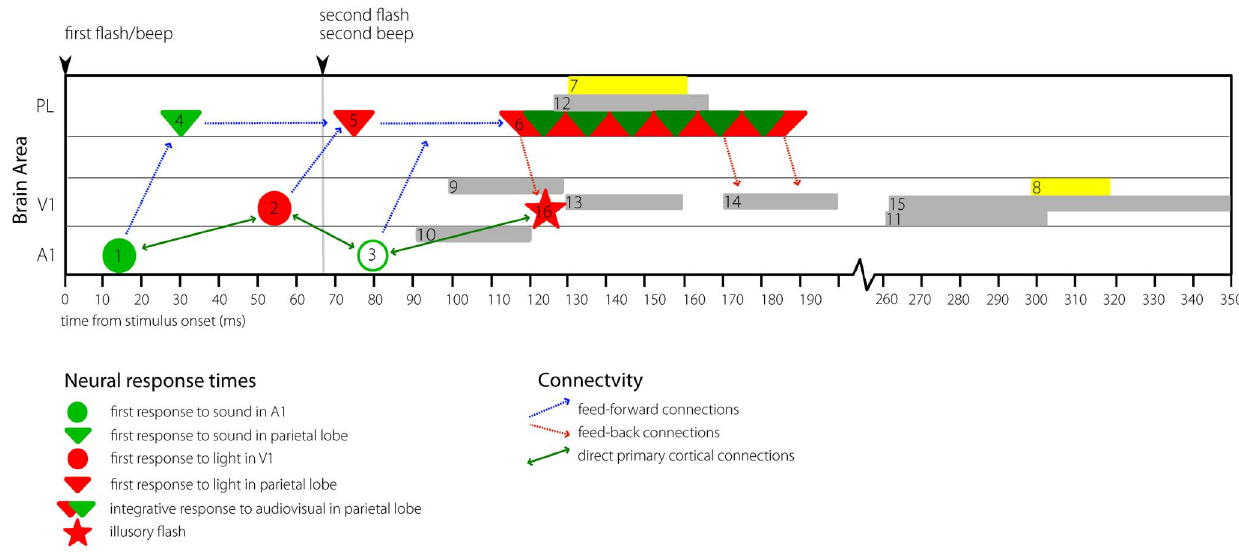
Figure 8. Timing Diagram. Diagram showing various responses to a simultaneous flash/beep stimulus at time zero. A1 – Primary Auditory Cortex, V1 – Primary Visual Cortex, PL – Parietal Lobes. See text for explanation of numbered points.